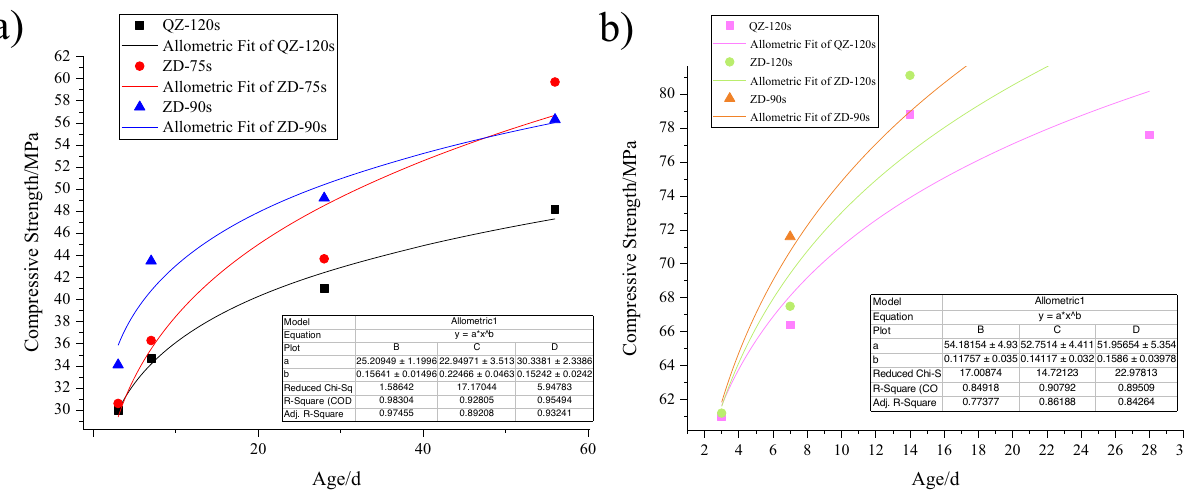
Figure 9: Concrete strength changes with age. ( a ) C40 concrete compressive strength with age. ( b ) C60 concrete compressive strength with age.